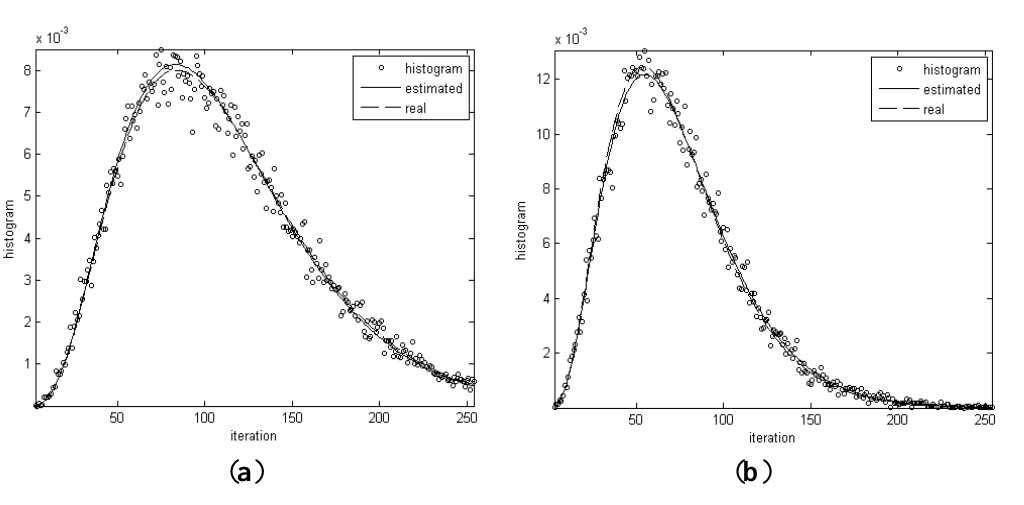
Figure 4. Histogram and curves of gamma distributions with real and estimated model parameters.